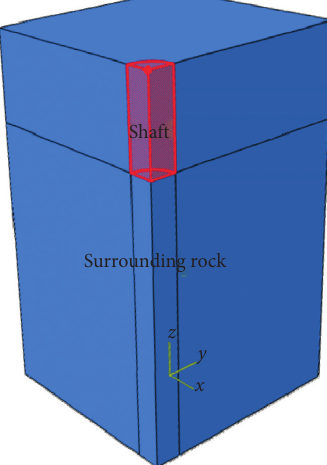
Figure 3: Model geometry